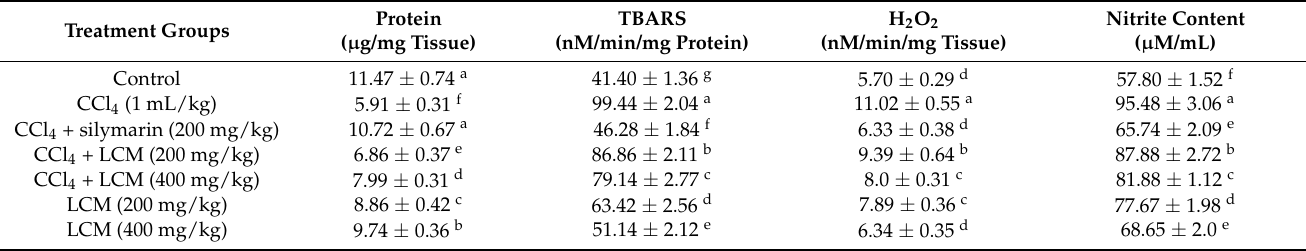
Table 7. Effect of L. corymbulosum on hepatic proteins, TBARS, H 2 O 2 and nitrite content. Treatment Groups